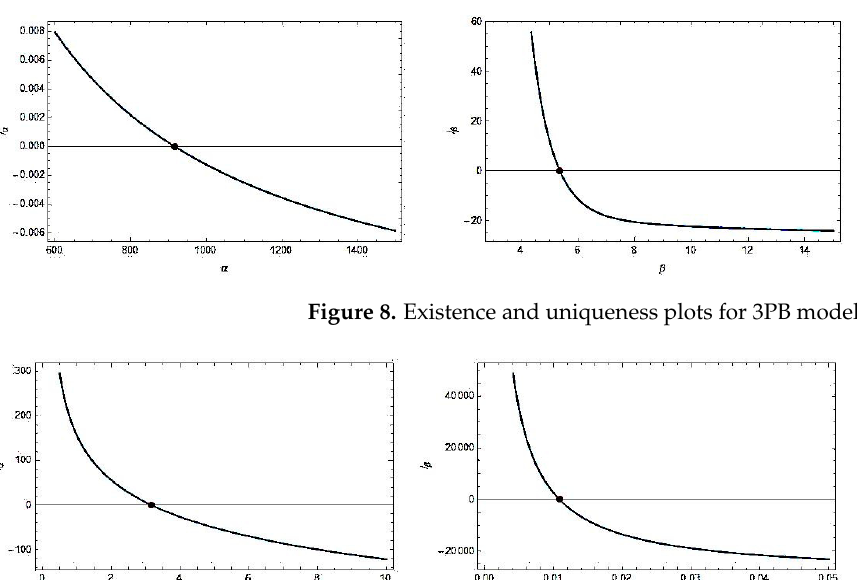
Figure 7. Histogram of stress ‐ rupture data with the estimated PDF, CDF, and SF of 3PB model with its P ‐ P plots.